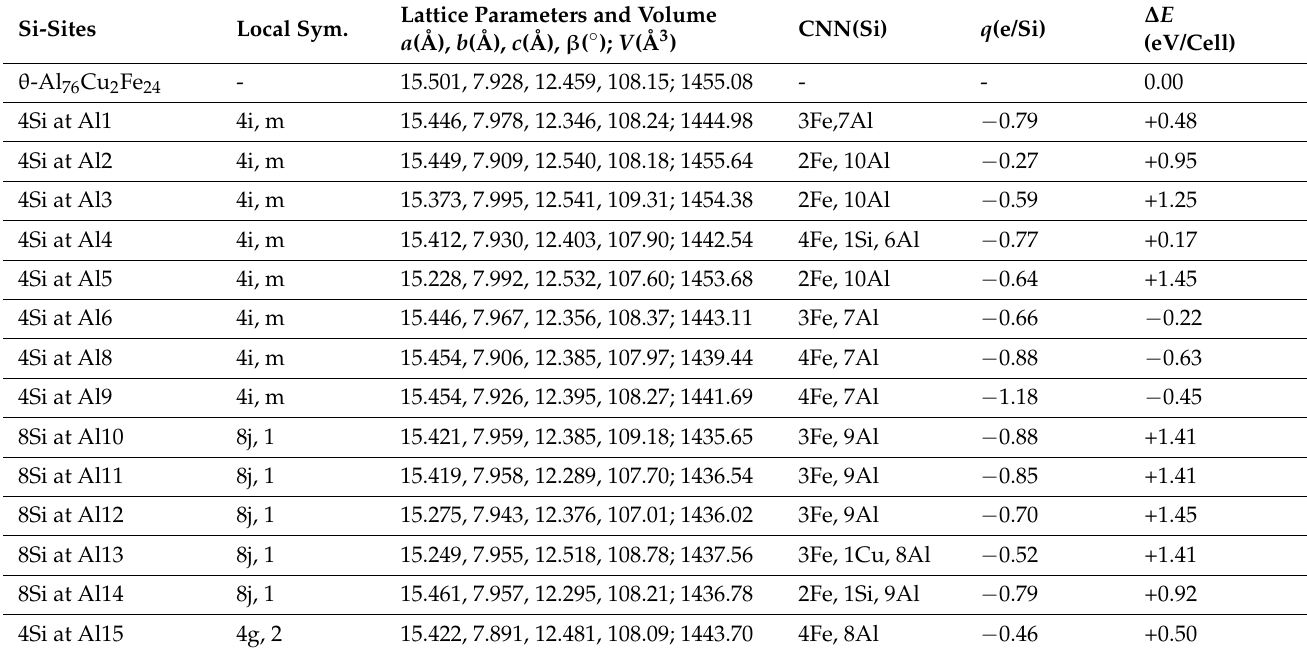
Table 1. The calculated results (lattice parameters, atomic coordinates, cell volumes, coordination numbers (CNN), Bader’s charges at the Si sites ( q ) and formation energies according to Equation (2) for Si solutions at the Al sites. The Wyckoff sites are fully replaced by Si and thus, the symmetry of the systems is the same as that of the θ -Al 13 Fe 4 (space group, C2/m) [19]. Si-Sites Local